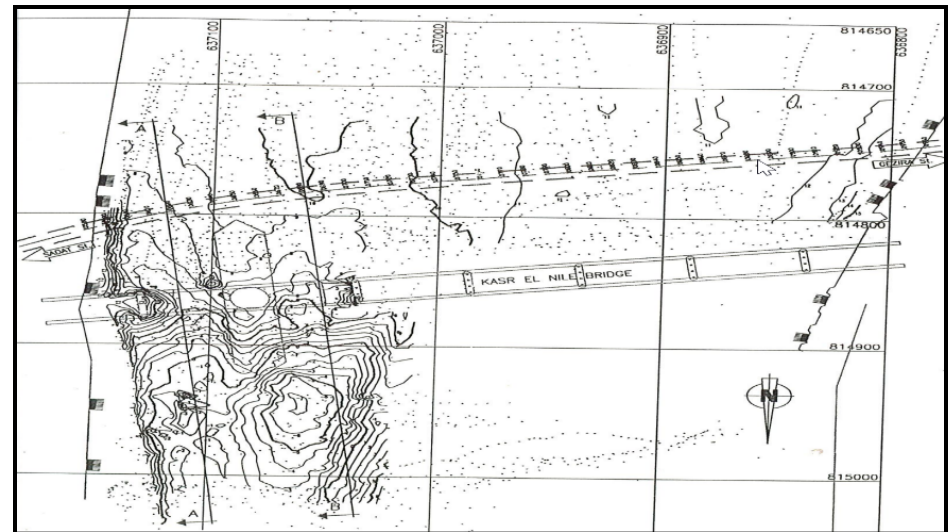
Figure 6. Bathymetric survey plan view.